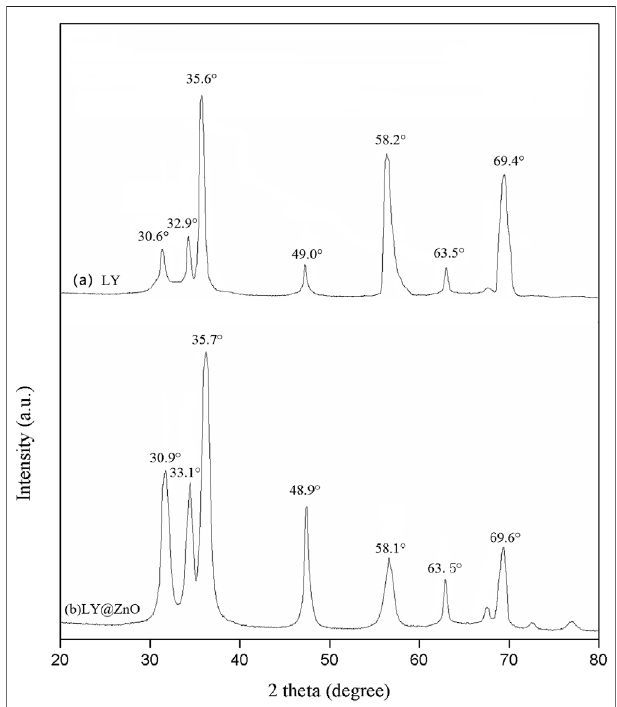
FIGURE 1 | XRD spectrum of (A) ZnO and (B) LY@ZnO NPs.